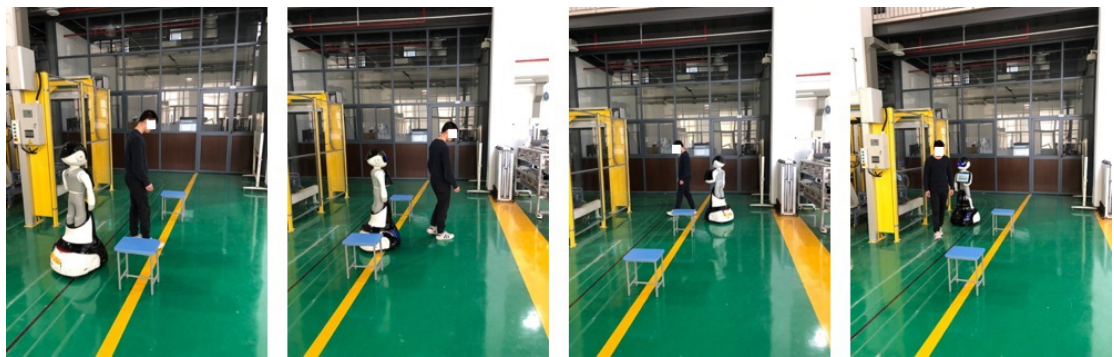
Figure 7. The target tracking robot following the experimenter in an S-shaped path.